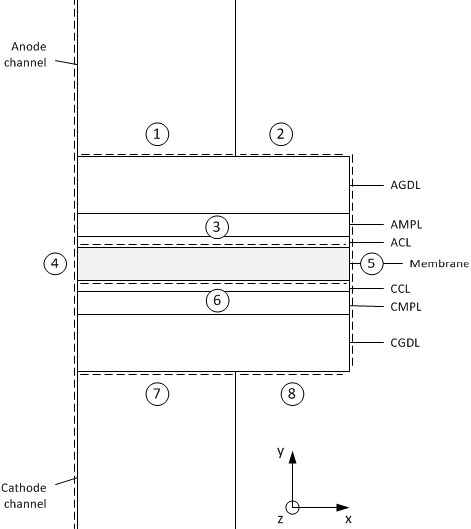
Figure 3. Schematics of the simulation domain and boundary condition regions.